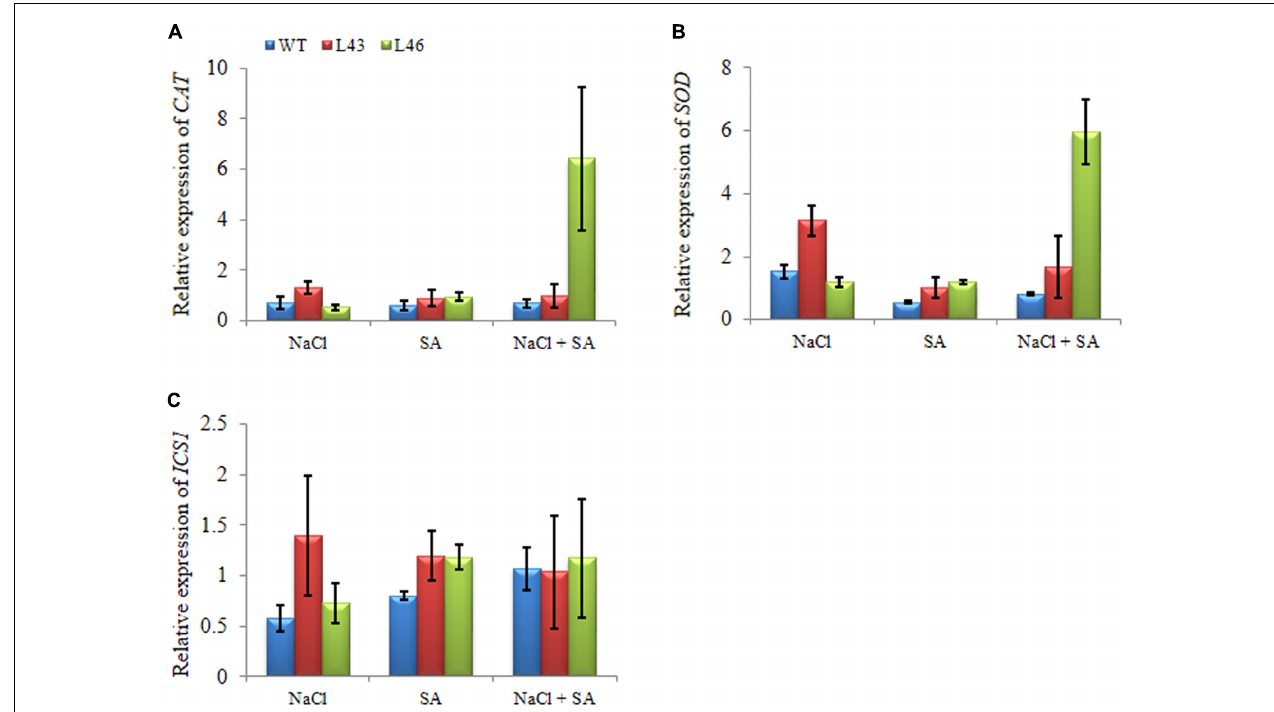
FIGURE 10 | Relative-fold expression of downstream genes in JcWRKY transgenics under different stress by real-time PCR; (A) CAT , (B) SOD , and (C) ICS1. Values are represented as mean ± SE ( n =